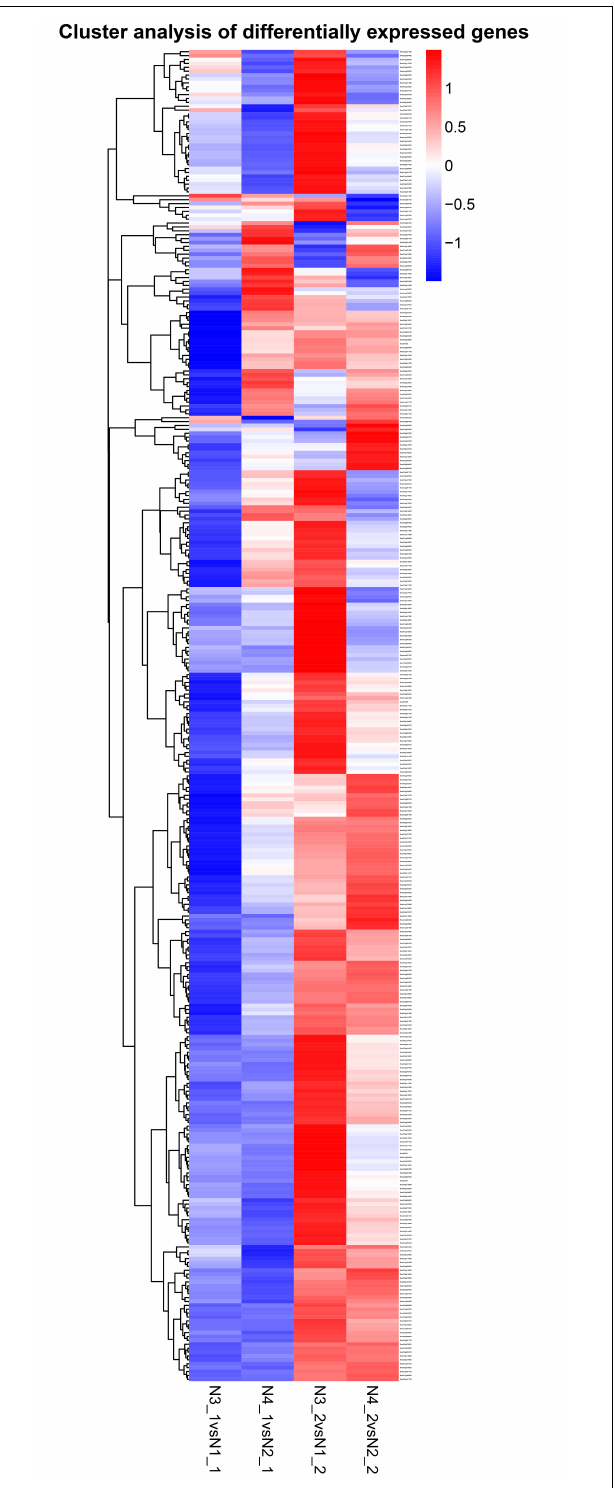
FIGURE 7 | Hierarchical cluster analyses of 342 common DEGs after GR24 treatment. This map shows the genes of log 2 (foldchange) values of the GR24 effects on shoot and root. The “N3_1 vs N1_1” indicates a comparison between the gene expression in the N3_1 library with that in the N1_1 library, and the same describes the other